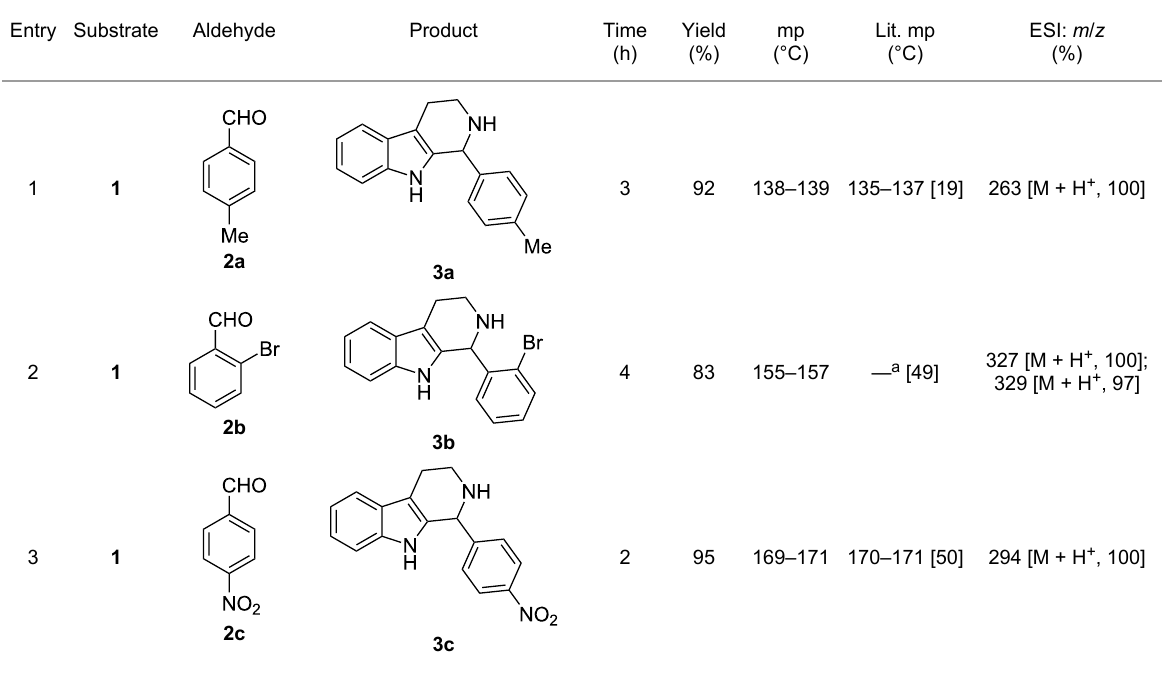
Table 2: Condensation of the Pictet–Spengler substrates 1 and 4 (1 equiv) with aldehyde (1 equiv) in the presence of TCT (20 mol %) in DMSO under a nitrogen atmosphere. Entry Substrate